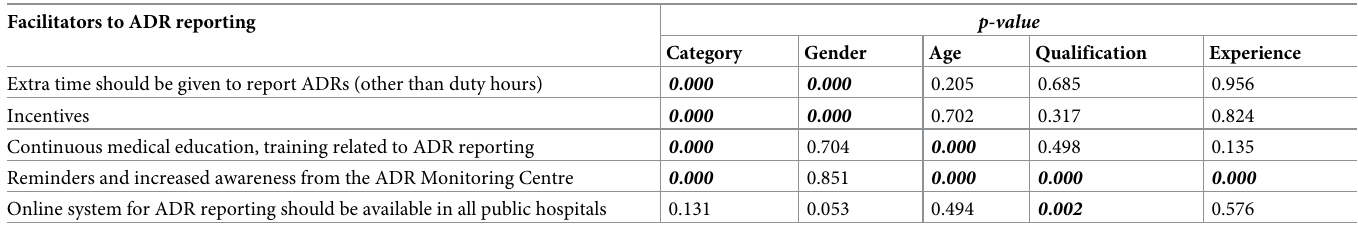
Table 5. Significance of ADRs related facilitators based on demographic characteristics.